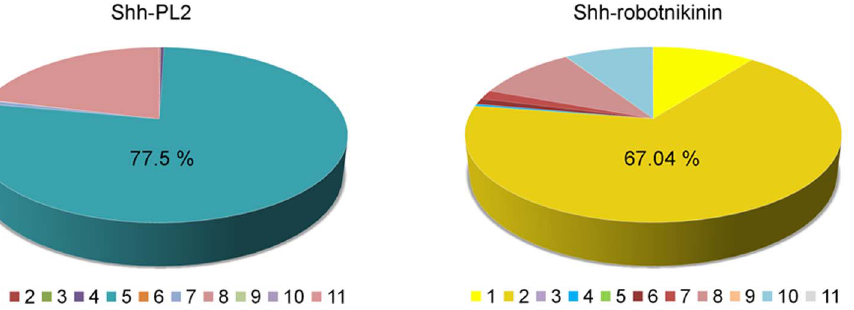
Figure 3. Pie charts of the clusters for backbone conformations of the Shh. (a) The highly populated cluster (cluster 5) of Shh-PL2 is colored in slashdot green. (b) The highly populated cluster (cluster 2) of the Shh-robotnikinin is colored in